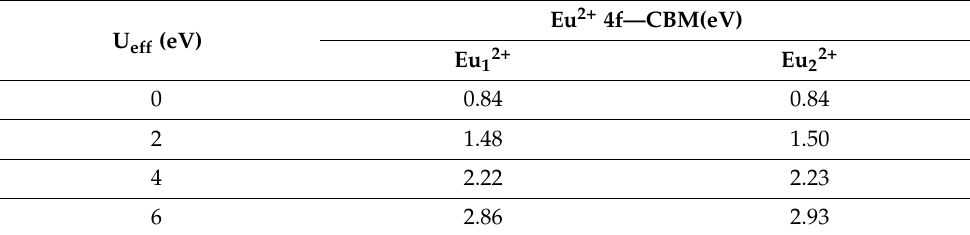
Table 5. Energy level difference of Eu 4f-CBM of Sr 2 Si 5 N 8 :Eu 2+ with different Ueff